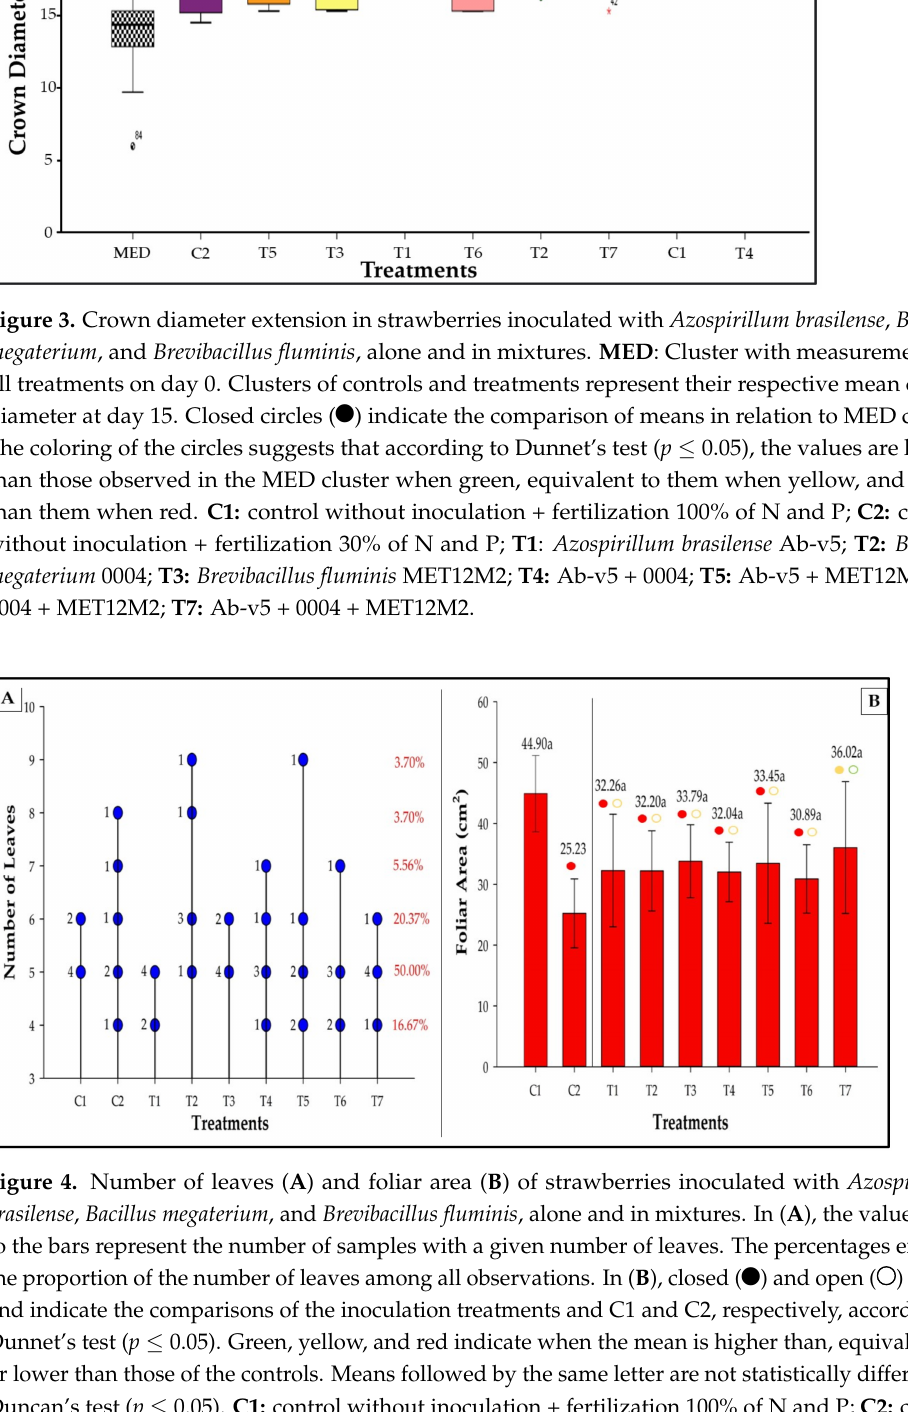
Table 3. Photosynthetic efficiency (PE), stomatal conductance (gs), internal CO 2 concentration (Ci), leaf transpiration (T), water use efficiency (WUE), and carboxylation efficiency (CUE) in strawberries inoculated with Azospirillum brasilense , Bacillus megaterium , and Brevibacillus fluminis , alone and in mixtures. Means are followed by their standard deviations.